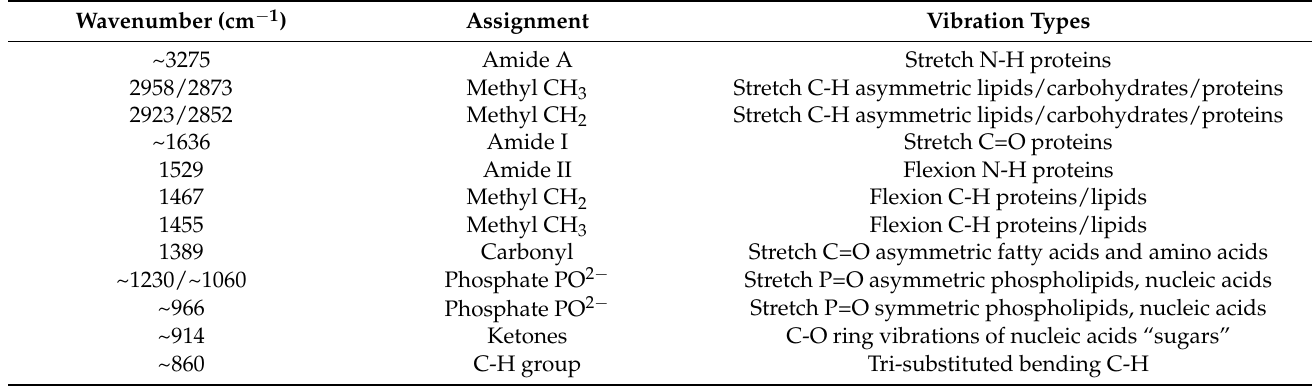
Table 4. Functional group identification of Cd-tolerant